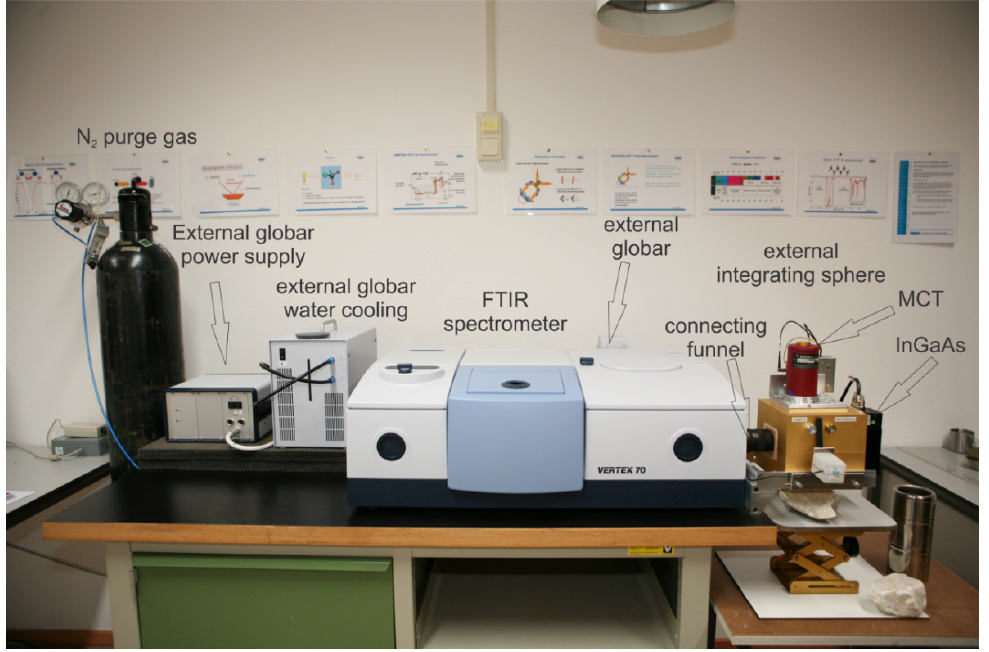
Figure 1. Overview of entire instrument setup with external components